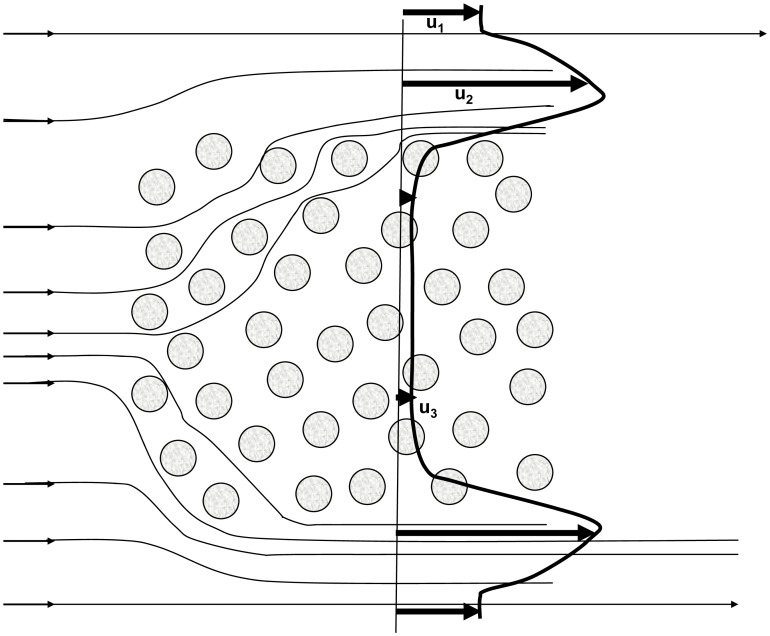
A schematic of the ‘sticky-water’ effect in a reef system under a steady current.The circles represent reefs, the thin lines represent streamlines of the mean currents, and the thick line is the distribution of the mean currents along a transverse section, extending from the surrounding waters in through the reefs and out to the surrounding waters. The penetration of water circulation inside the archipelago is asymmetric, being larger on the upstream side than on the downstream side. The thin, straight vertical line is a transverse section, inserted for comparative purposes, to show the different vectors for u1, u2, and u3. The sticky water effect generates slower mean currents (u3) inside the archipelago compared with currents surrounding the archipelago (u1). The deflection of the mean circulation around the archipelago also generates a boundary layer where the currents are even faster than elsewhere (u2), so that u2> u1> u3.